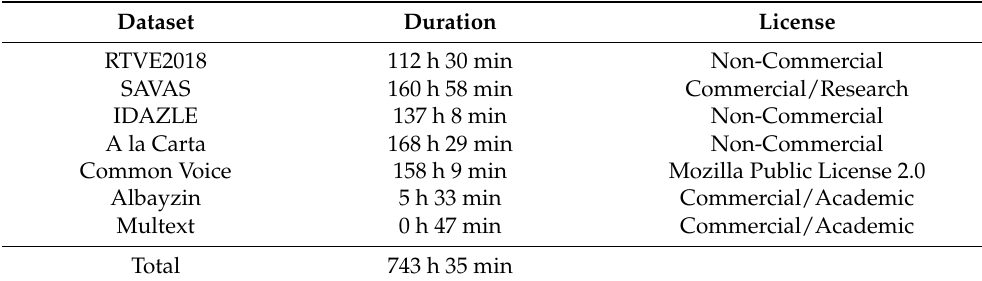
Table 1. Duration of the speech segments for each dataset with their corresponding